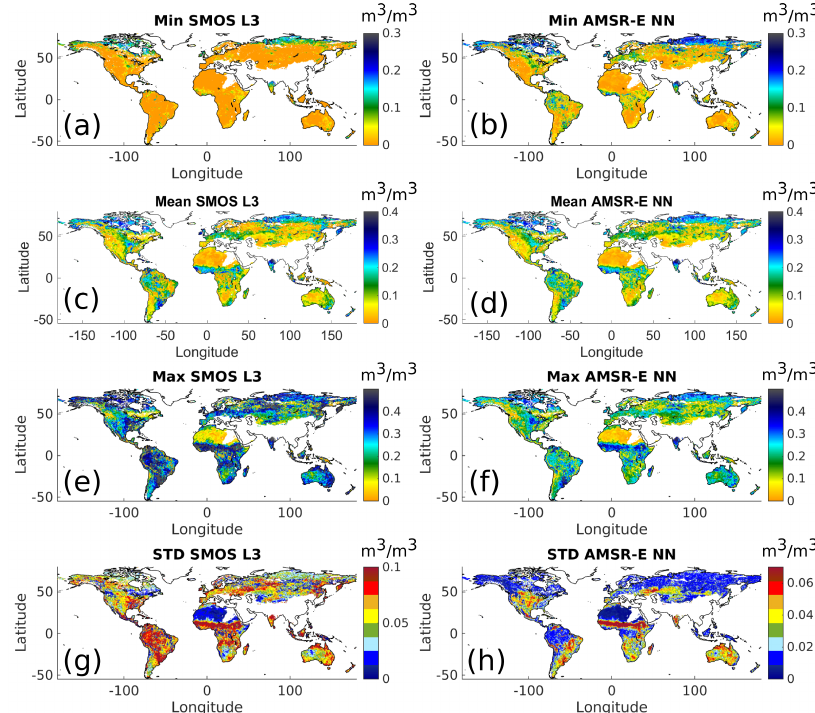
Figure 5. Maps of different statistics metrics for the SMOS L3 SM dataset (left panels) and AMSR-E NN SM (right panels) computed from June 2010–October 2011: minimum values ( a , b ); mean ( c , d ); maximum ( e , f ); and standard deviation ( g , h ).